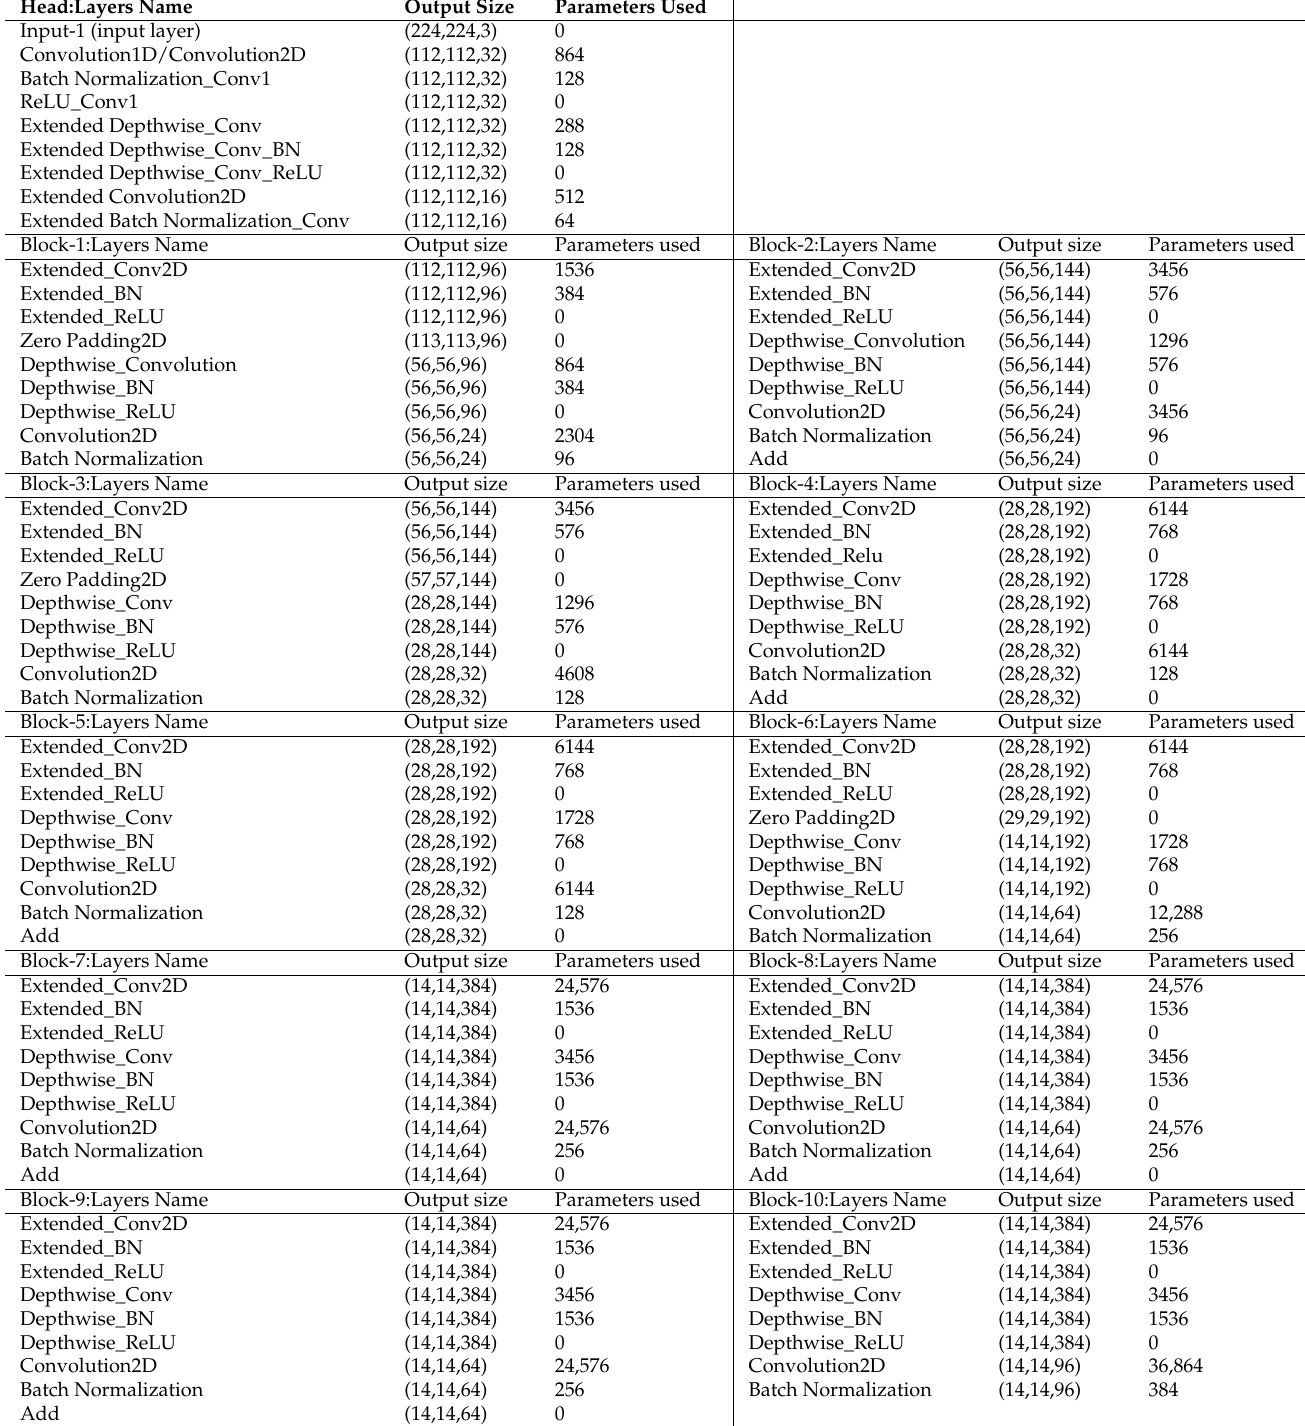
Table 1. Architecture of the Proposed